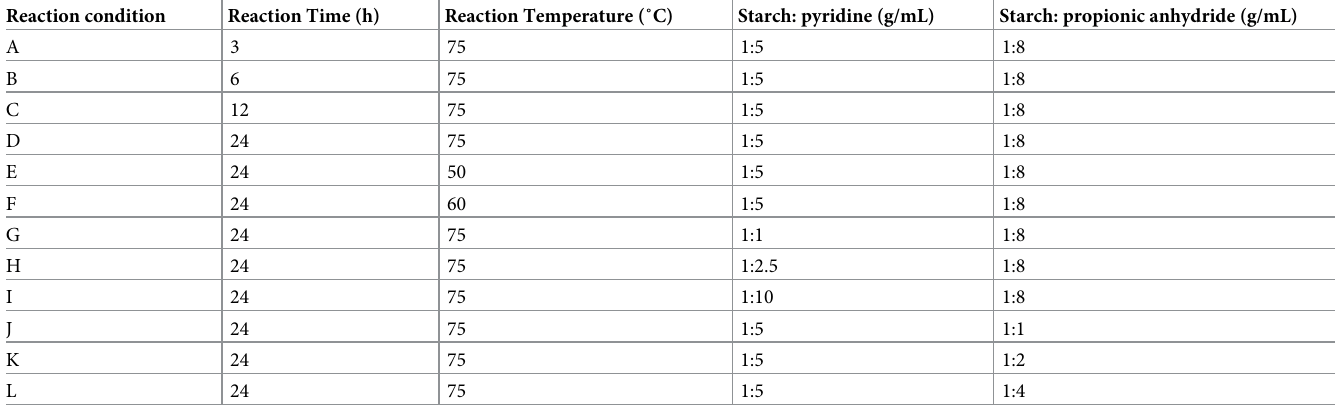
Table 1. Reaction conditions for the synthesis of PDAS. Reaction